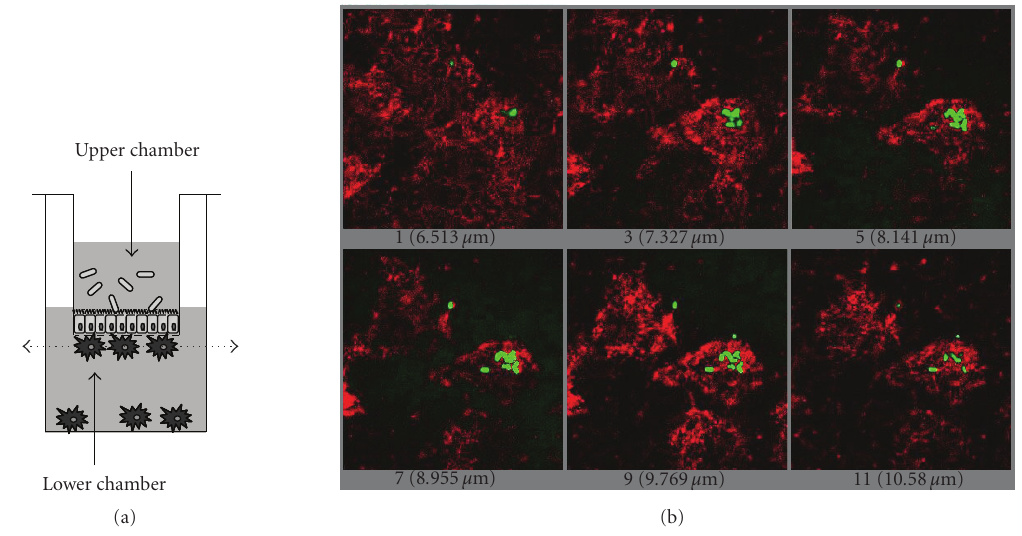
Figure 1: Confocal analysis of FITC-labelled L. casei uptake by adherent DC . (a) Schematic view of the DC/epithelial cell culture model. The dotted arrow indicates the section where the analysis was done. (b) The pictures represent di ff erent sections of the same DC and show the colocalization of FITC-bacteria into the cytoplasm of